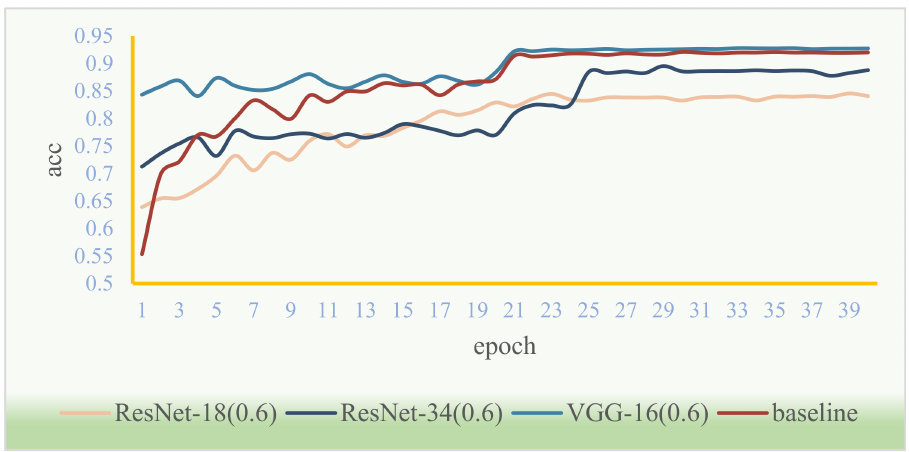
Figure 12. Accuracy comparison between different models at a pruning rate of 0.6.